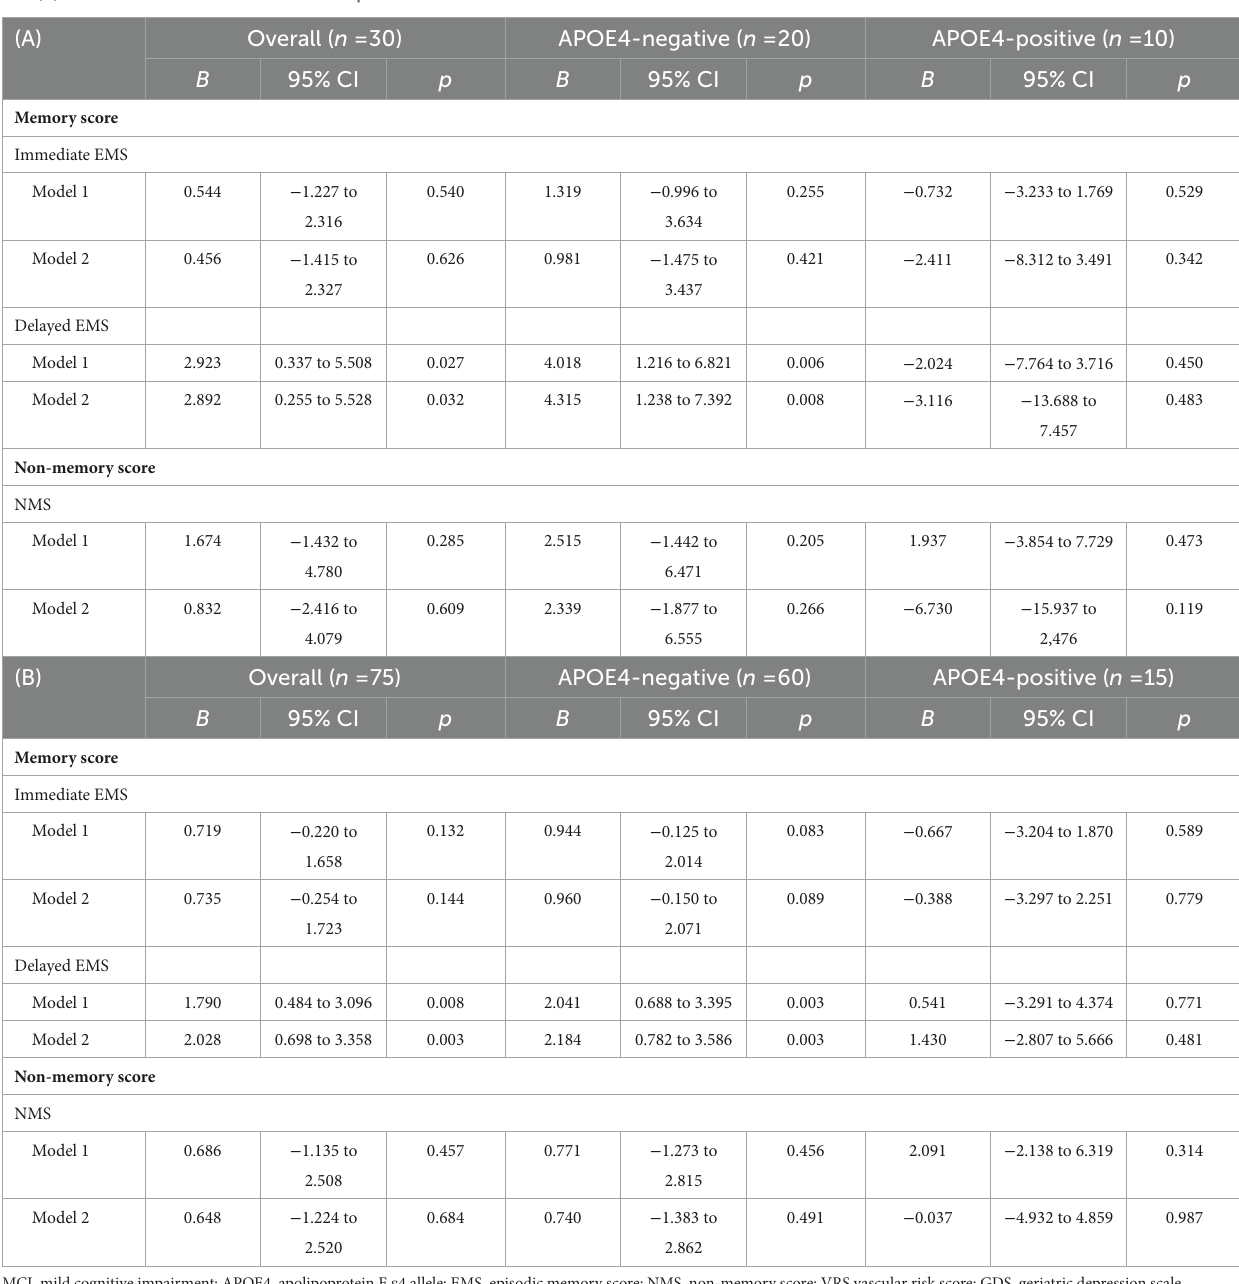
TABLE 7 Results of the multiple linear regression analyses of the association between ginseng intake status and cognition in participants with (A) MCI and (B) no decrease in food intake over the past 3